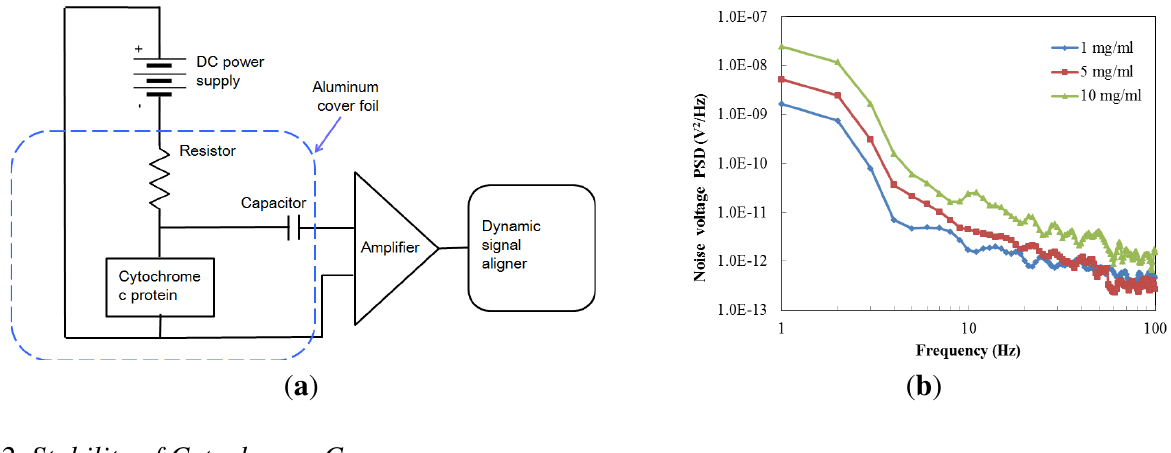
Figure 7. ( a ) 1/f noise measurement setup at different protein concentrations